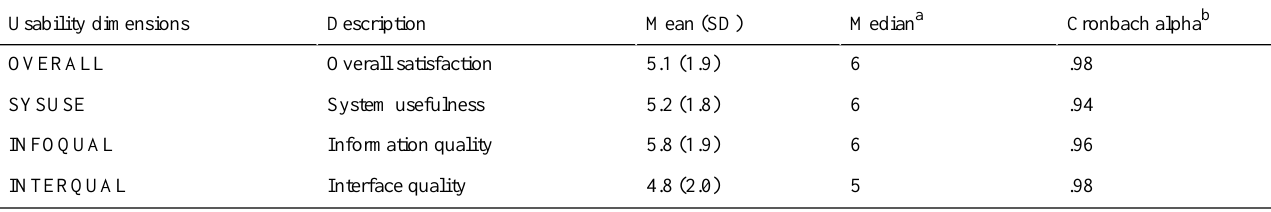
Table 1. Results according to the dimensions of the Poststudy System Usability Questionnaire [11].